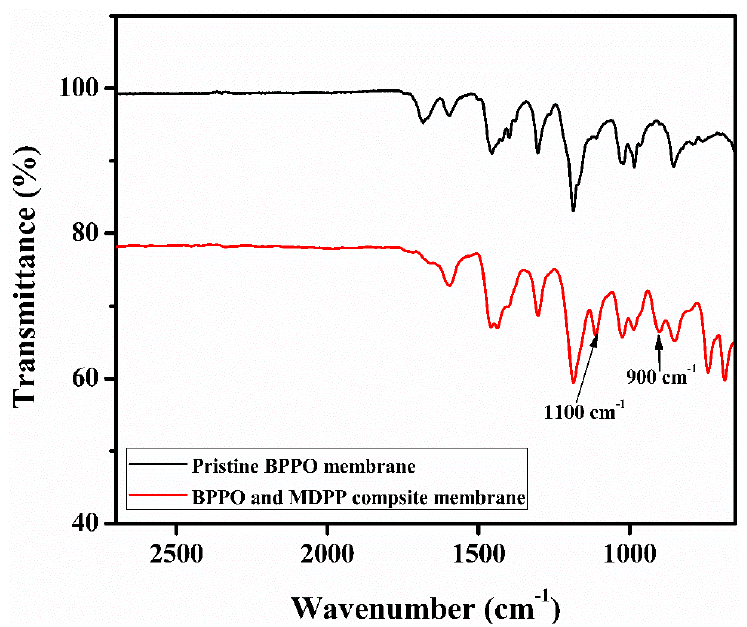
Figure 2. The IR spectrum of different anion exchange pristine BPPO membranes and BPPO and MDPP composite membranes.